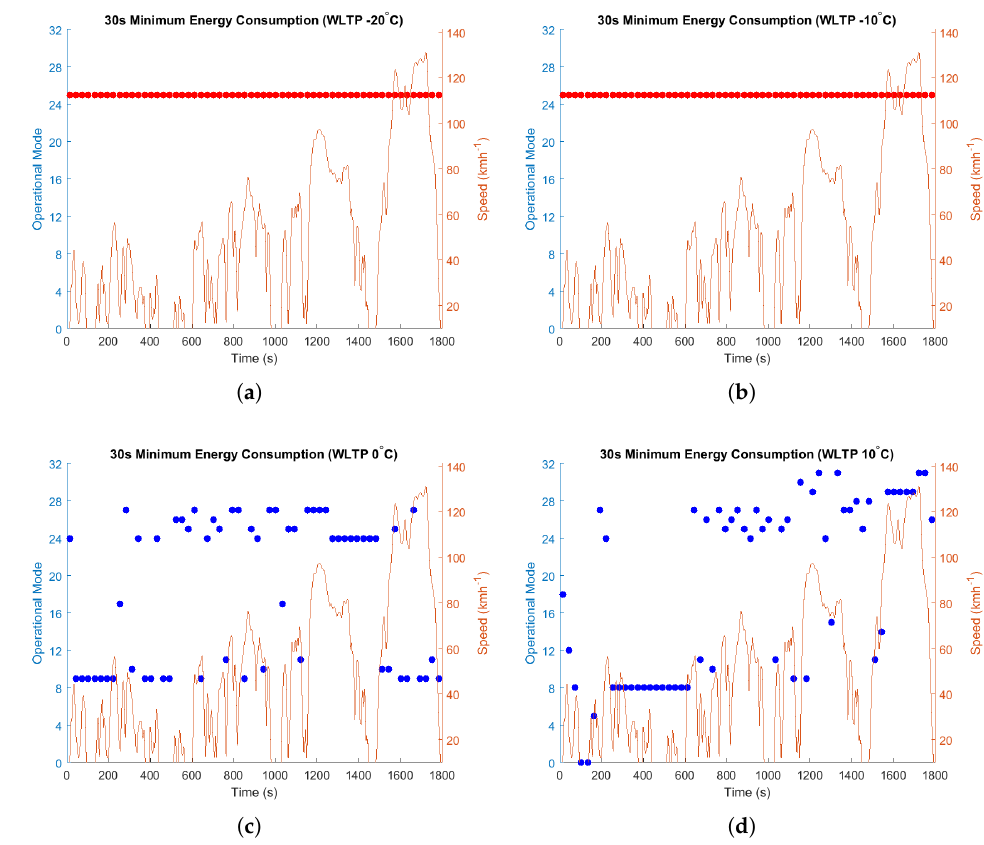
Figure 9. The best operational mode during 30 s intervals as a function of time is shown through the Warm up drive cycle over temperatures − 20 ◦ C ( a ), − 10 ◦ C ( b ), 0 ◦ C ( c ) and 10 ◦ C ( d ). Blue dots show the operational mode which used the least energy during that 30 s interval. This has been overlaid with the WLTP cycle. Red dots indicate when no operational mode met cabin target temperature, blue dots indicate multiple operational modes met cabin target